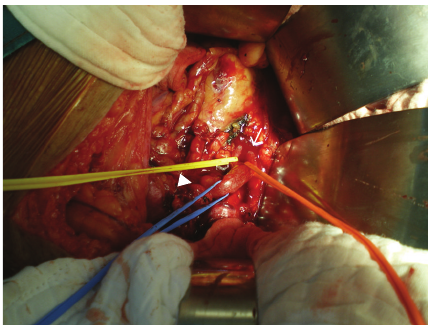
Figure 3: The bifurcation of the right dilated ureter (arrow) was found above the right internal iliac artery aneurysm (arrow